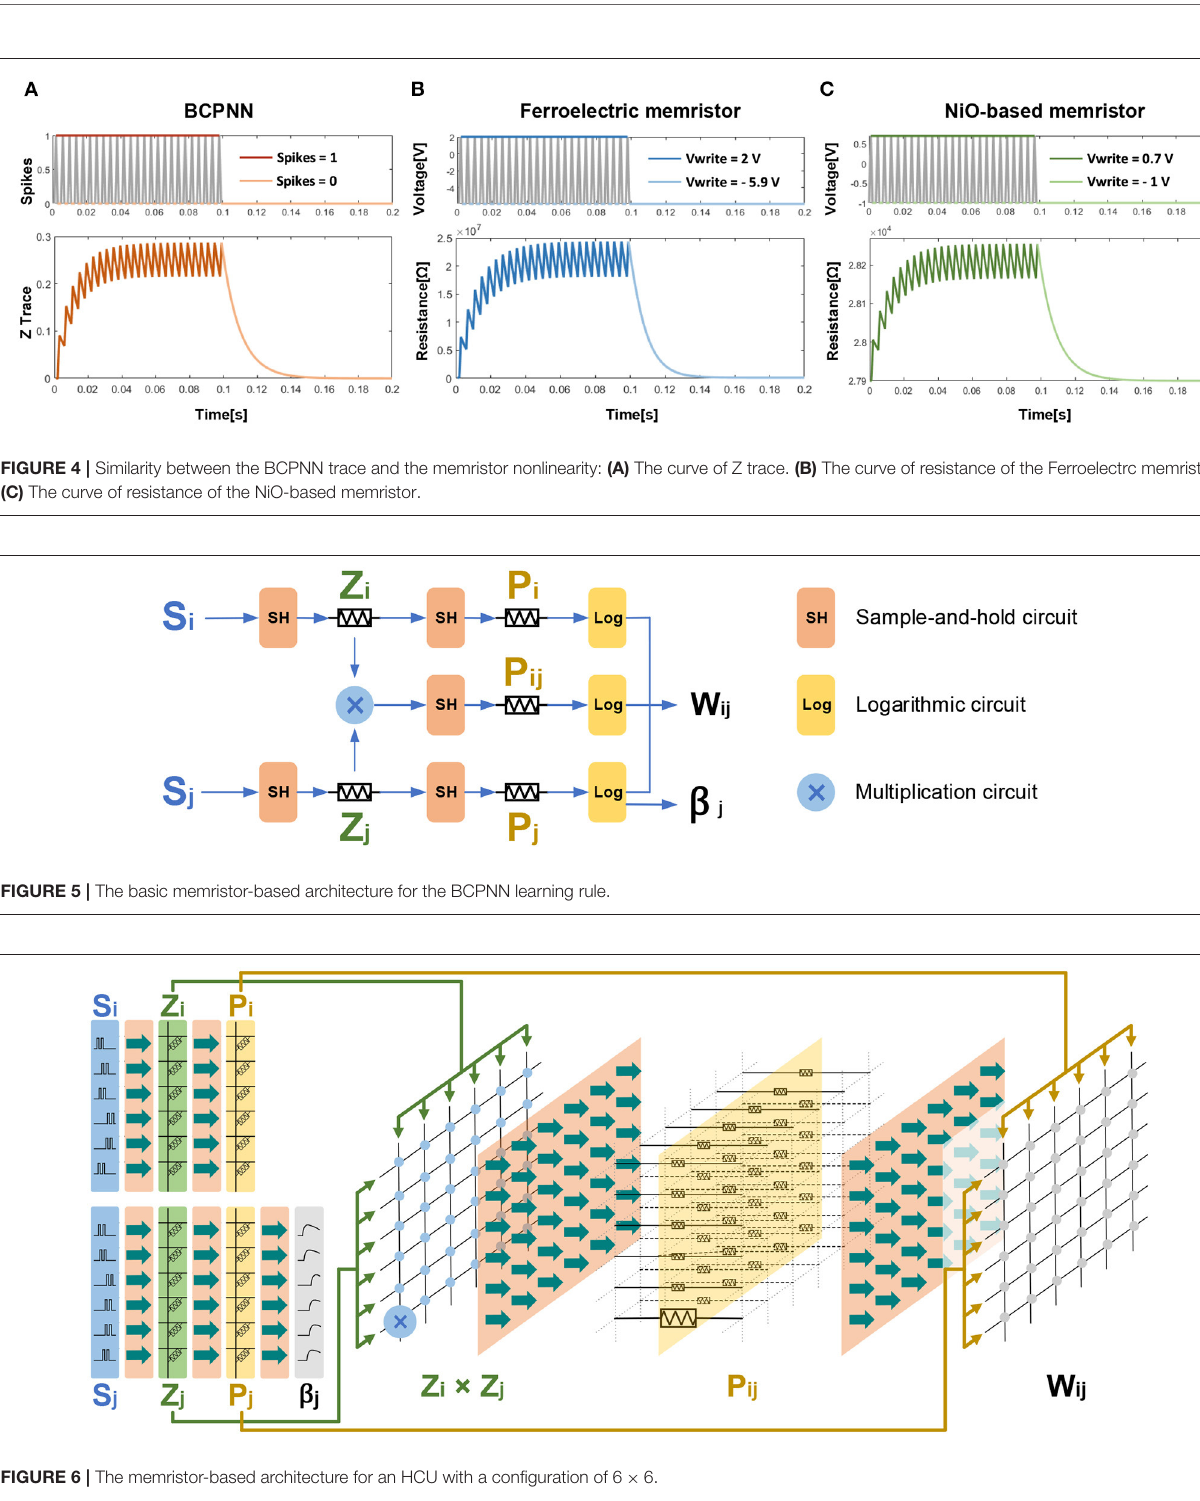
state x is moving toward 1. The parameter j determines the magnitude, and the parameter p controls the decrease rate of the window function when approaching the boundaries. When p approaches 0, the non-linearity is weakened.